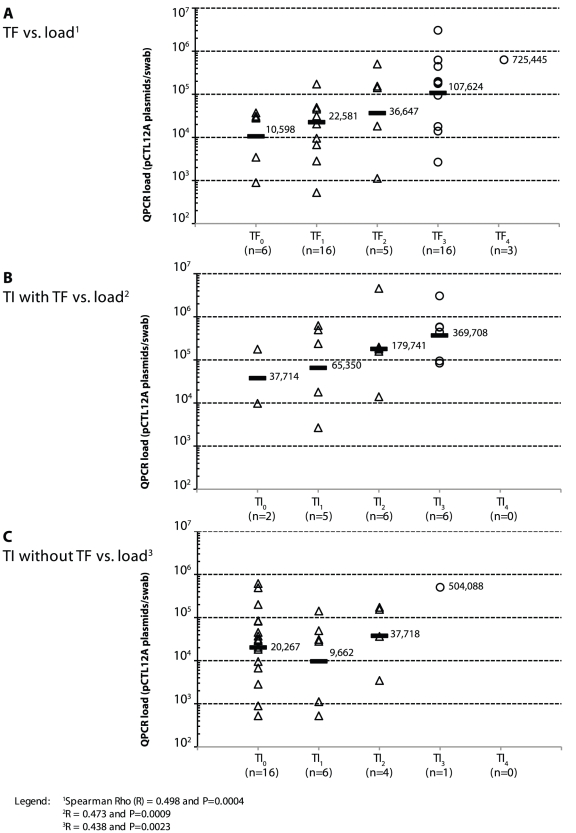
Organism load versus fine left eye clinical grading.
Fig. 5A: TF0–4 vs. load1; Fig.
5B: TI0–4 in presence of TFWHO
vs. load2; Fig. 5C: TI0–4 in
absence of TFWHO vs. load3.